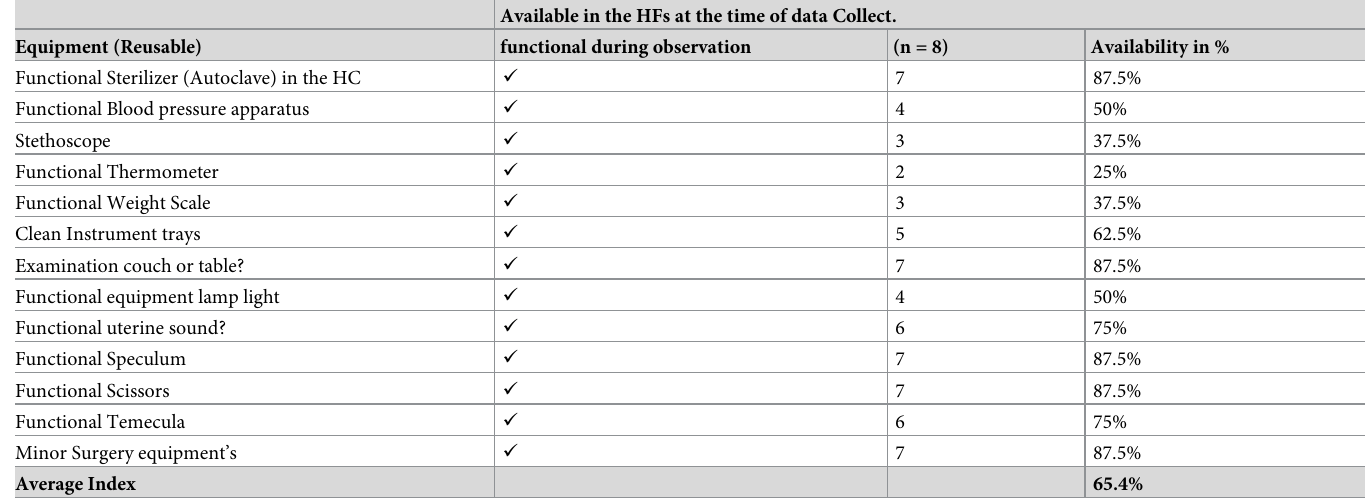
Table 1. Equipment and supplies available for family planning service delivery at Gondar city public health facilities, Northwest Ethiopia, 2020. Available in the HFs at the time of data